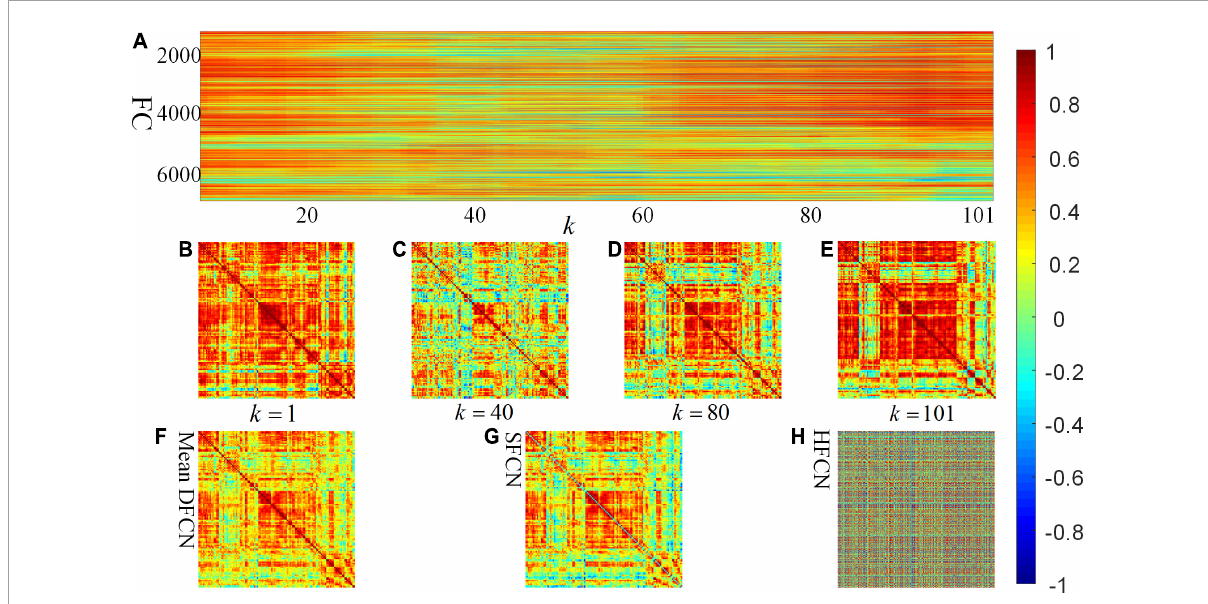
FIGURE3 Visualization of SFCN, DFCN, and HFCN when the window length L = 40. (A) All the rearranged DFCN upper triangular elements along the time window, where the horizontal axis represents the 101 time windows, and the vertical axis represents the 7,140 functional connectivities. (B–E) The DFCN sub-networks under the k -th time windows, where k = 1, k = 40, k = 80, and k = 101, respectively. (F,G) The average of the sub-networks under whole time windows of DFCN and the static FC network based on pair-wise correlation of BOLD signals, respectively. (H) The constructed high-order FC network.